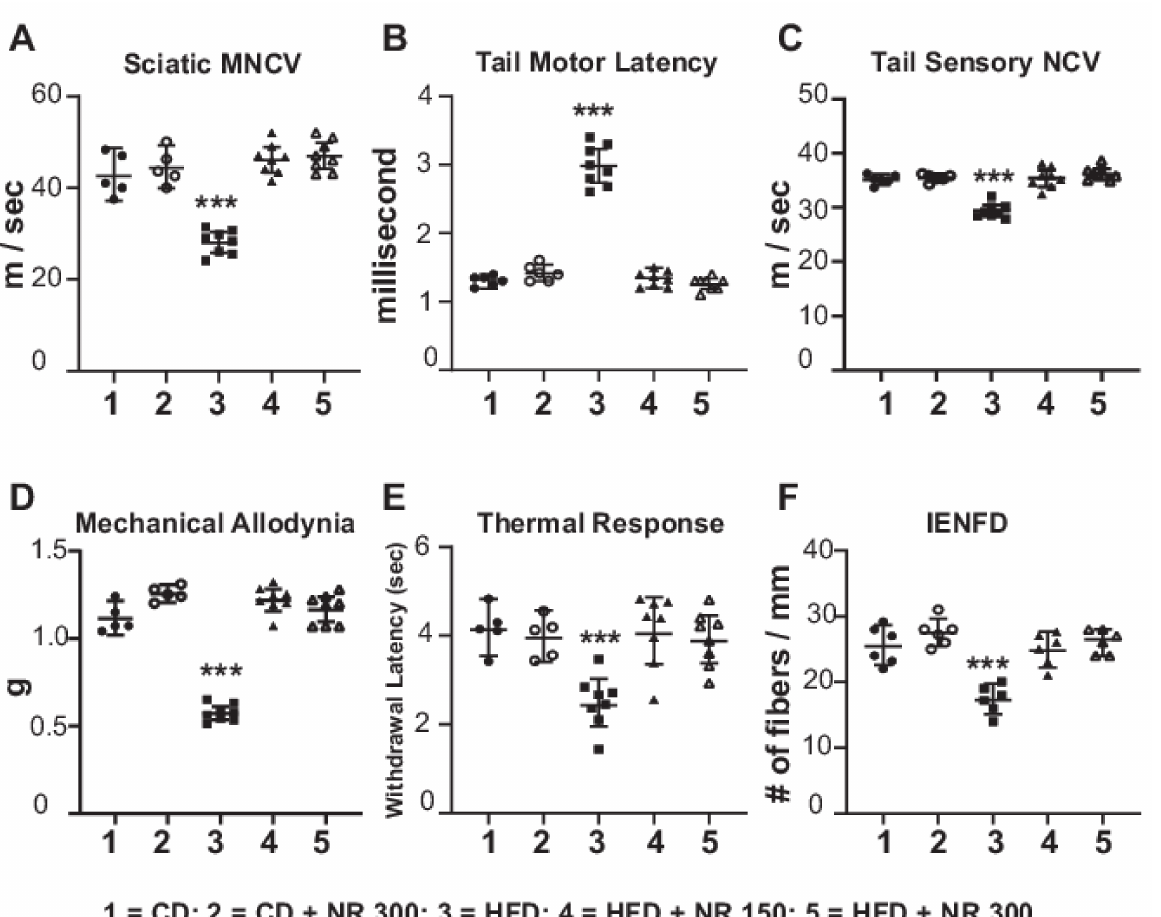
Figure 2. NR prevents HFD-induced neuropathy in C57Bl6 mice ( n = 6 to 8 per group). WT C57BL6 mice were randomly assigned to five groups of six to eight mice per group. Group # 1: CD; Group # 2: CD + NR 300 mg/kg; Group # 3: HFD; Group # 4: HFD + NR (150 mg/kg); and Group # 5: HFD + NR (300 mg/kg). NR was added to the diet at the dose mentioned to the groups indicated for 2 months. The mice were tested for the following parameters: sciatic motor nerve conduction velocity, SMNCV, ( A ), tail motor latency, TML, ( B ), tail sensory nerve conduction velocity, TSNCV, ( C ), mechanical allodynia by von Frey filament paw withdrawal threshold ( D ), paw thermal sensitivity by Hargreaves test ( E ), and IENFD of the hind paw ( F ). Statistical comparisons were made between the five groups by ANOVA and post hoc Tukey test. *** p < 0.001; HFD, Group # 3 at 2 months compared to all other groups in all